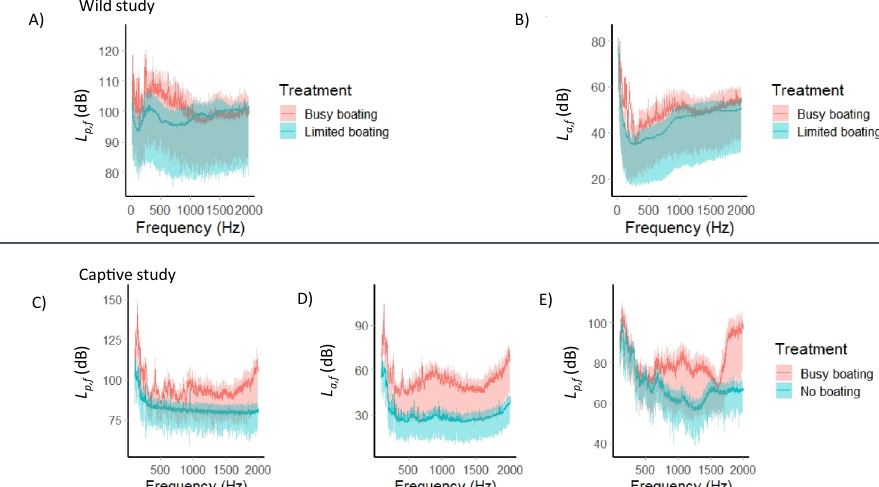
Fig. 6 Pressure power spectral density level ( L p,f (re 1 µ Pa 2 Hz − 1 )) and particle acceleration power spectral density level ( L a,f (re 1 ( µ m s − 2 ) 2 Hz − 1